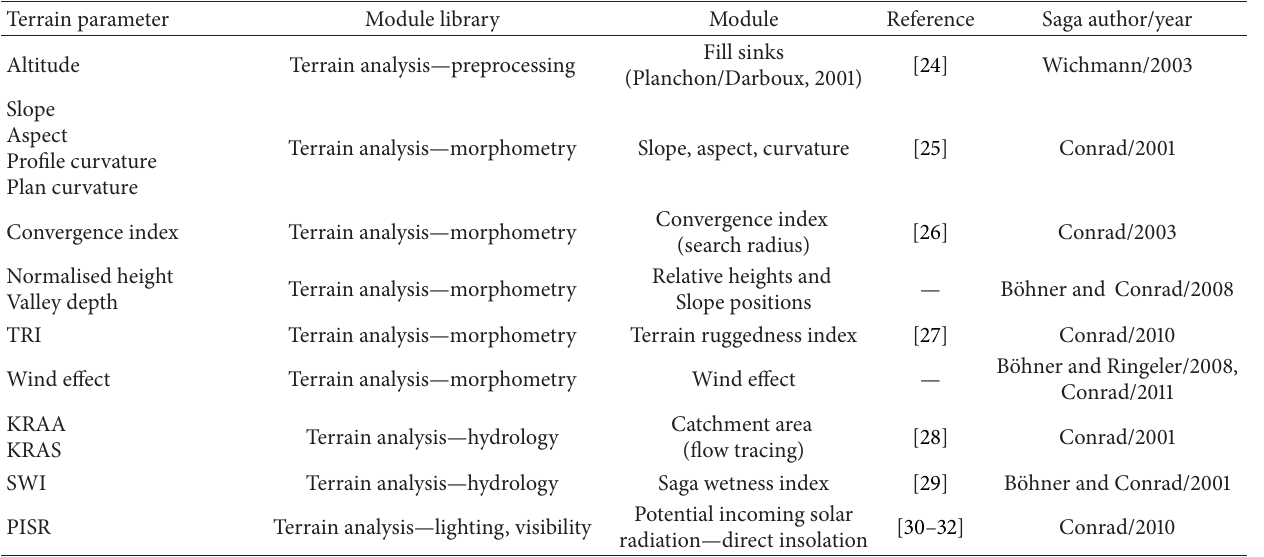
Table 1: SAGA modules to calculate terrain